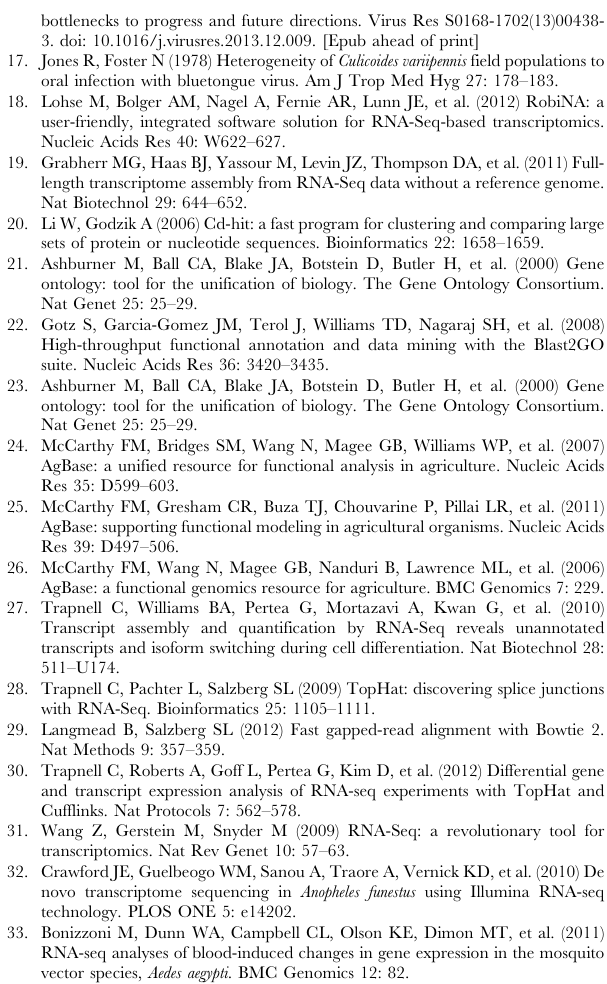
Figure S1 Transcriptional response to sucrose feeding in female Culicoides sonorensis . Numbers of genes classified within GO-slim categories that were upregulated (blue) or downregulated (red) in response to sucrose feeding are shown, including comparisons of (A) teneral versus an early sucrose meal (B) teneral versus an late sucrose meal, and (C) early sucrose meal versus late sucrose meal. Figure S2 Multiple alignment of midge and mosquito vitellogenins. Full amino acid sequences for Culicoides sonorensis, Aedes aegypti and Culex pipiens vitellogenins were aligned using ClustalW algorithm in the Mega5 software (www.megasoftware. net). (PPTX) File S1 Tables S1–S12. Table S1. Sample trimming results of 2 6 101 bp PE Illumina. Table S2. BlastX alignment of the Culicoides unigene to the NR, and Aedes and Culex transcriptomes. Table S3. Unique GO accessions of the Culicoides transcriptome mapped to the GO database. Table S4. Top 100 genes with at least 2-fold increase in abundance in early response to a blood meal. Table S5. Effect of blood feeding on differential expression of genes in female Culicoides sonorensis . Table S6. Significant